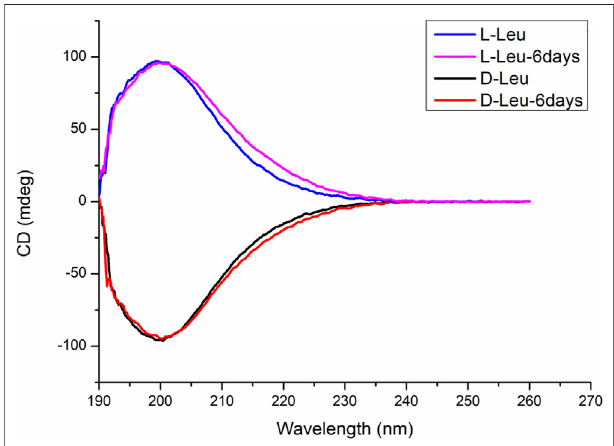
FIGURE 2 | CD spectra of four chiral Leu. Blue line: the CD spectrum is derived from freshly prepared L-Leu aqueous solutions. Purple line: the CD spectrum of L-Leu in an initial pH 11.7 at 35 ° C for 6 days Black line: the CD spectrum is derived from freshly prepared D-Leu aqueous solutions. Red line: the CD spectrum of D-Leu in an initial pH 11.7 at 35 ° C for 6 d. The results showed that L-Leu or D-Leu did not undergo chiral racemization in the experiment reaction